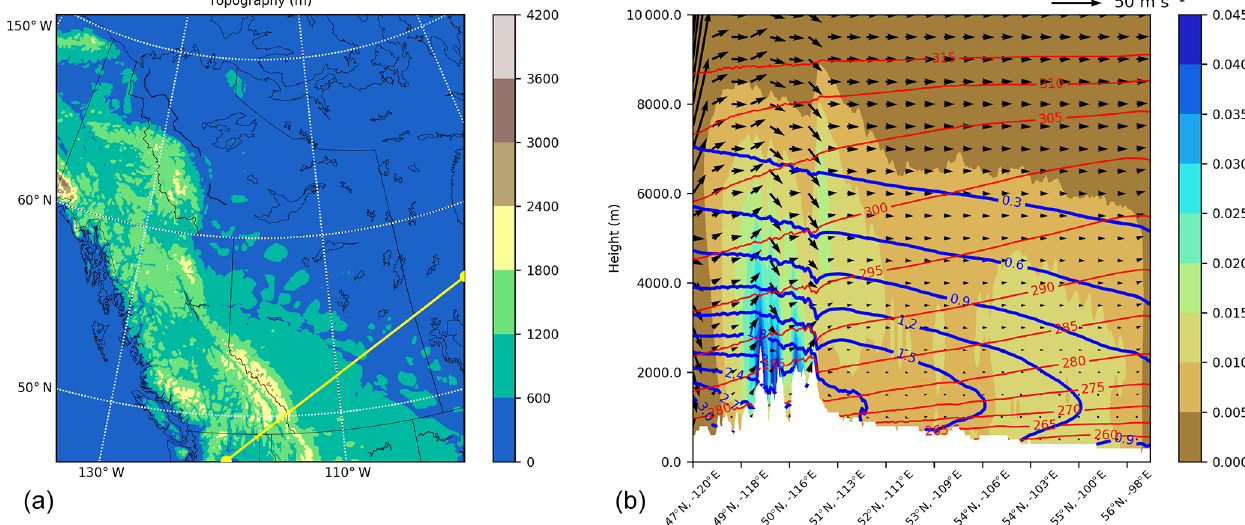
Figure 7. (a) Topography in western Canada. (b) Cross section of potential temperature (K; thin red contour); water vapour mixing ratio (gkg − 1 ; thick blue contour); the sum of snow, ice, and graupel mixing ratio (gkg − 1 ; shading); and wind (ms − 1 ) perpendicular to the Canadian Rockies (115 ◦ W, 50 ◦ N) in December. The vertical component of wind is scaled to 100 for illustration